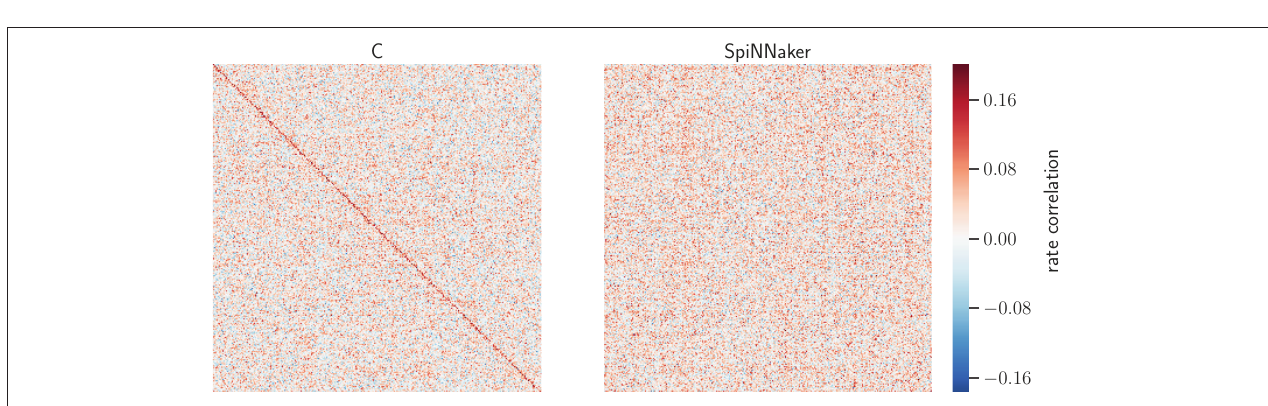
FIGURE 7 | Distributions of characteristic measures of network activity simulated with C and SpiNNaker after the final step of refinement. The top row shows single neuron statistics FR, LV, and the ISIs (same display and data specification as in Figure 5B ). The histograms of ISIs are displayed using semi-logarithmic scaling. The bottom row shows pairwise statistics and network properties, namely the CC using 2 ms bins, the rate correlation (RC) using 100 ms bins, and the eigenvalues ( λ ) of the RC matrices displayed on the vertical axis using a logarithmic scaling. Right: effect size using the same display as in Figure 6 . The effect sizes for the tested measures are FR: 0.41 0.08, LV: 0.28 0.09, ISI: 0.14 0.03, CC: 0.17 0.03, RC: 0.14 0.02, and λ : < 8 10 − 17 , respectively. ± ± ± ± ± ×